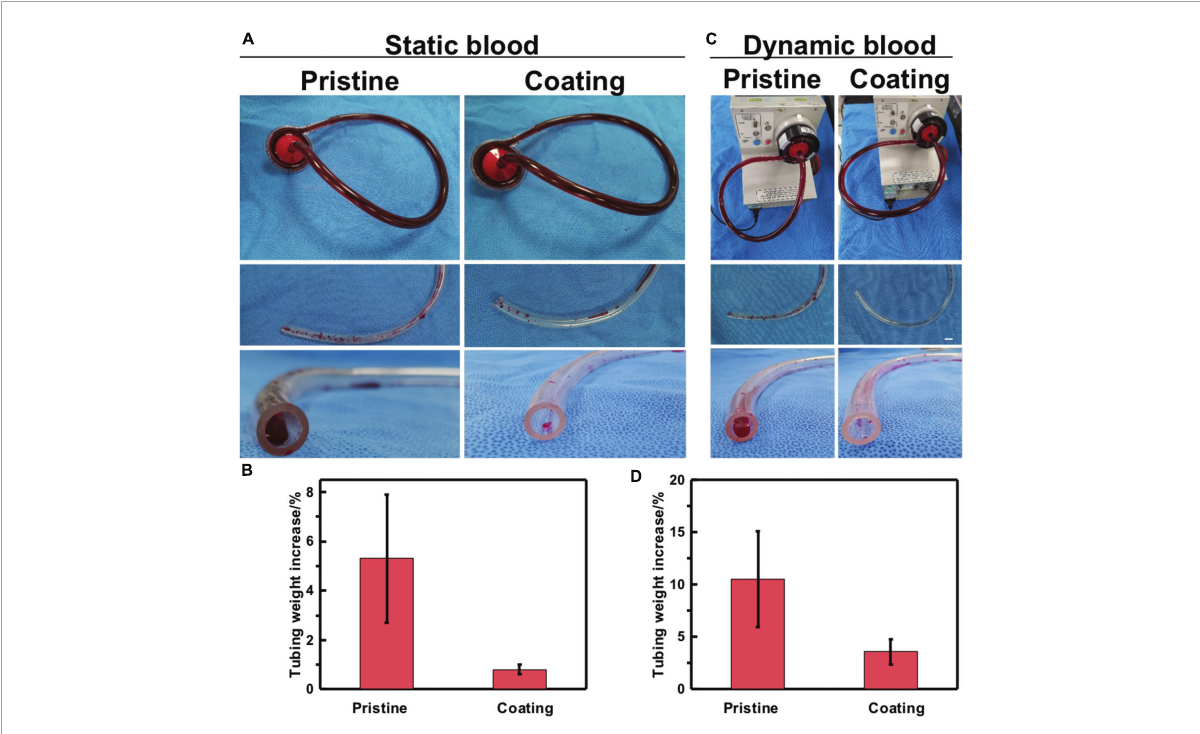
FIGURE4 In vitro blood loop tests of static blood and dynamic blood. (A) Image of apparatus used for continuous flow testing of pristine and coated tubing. Testing was done in parallel to accurately control the end time point of flow. (B) Quantification of blood clotting adhesion to the tubing walls in static blood. (C) Image of pristine and coated tubing after flow testing and gentle rinsing with saline. (D) Quantification of blood clotting adhesion to the tubing walls in dynamic blood. Error bars represent SD for three repeated